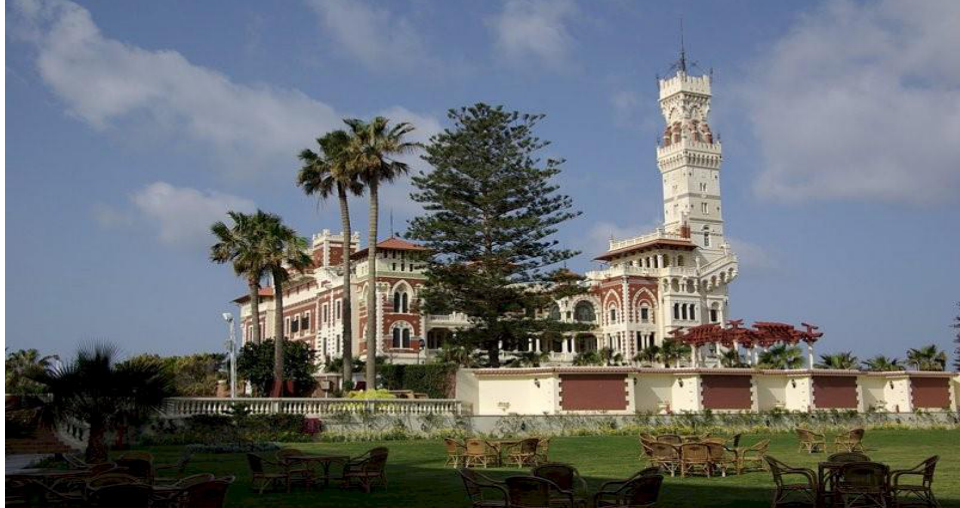
Figure 6: Montaza Palace (Montaza Royal Gardens 150 acres) - Alexandria (Egypt Travel Link,